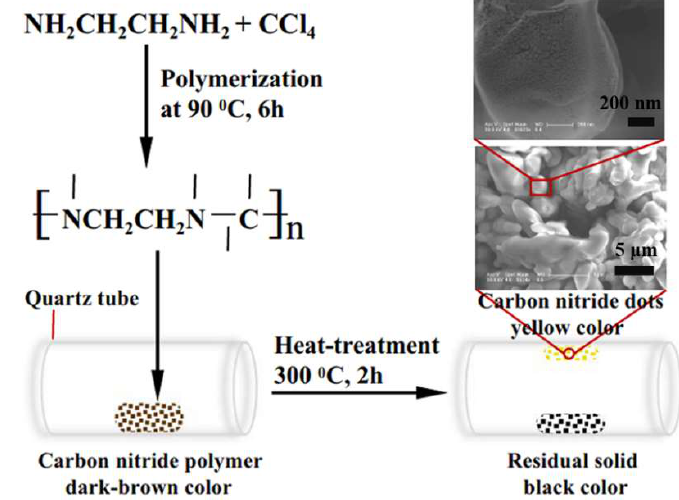
Figure 1. Schematic illustration of the procedure for preparing carbon nitride dots (CNDs).